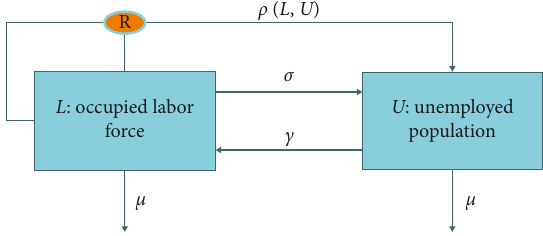
Figure 1: Scheme of the labor force